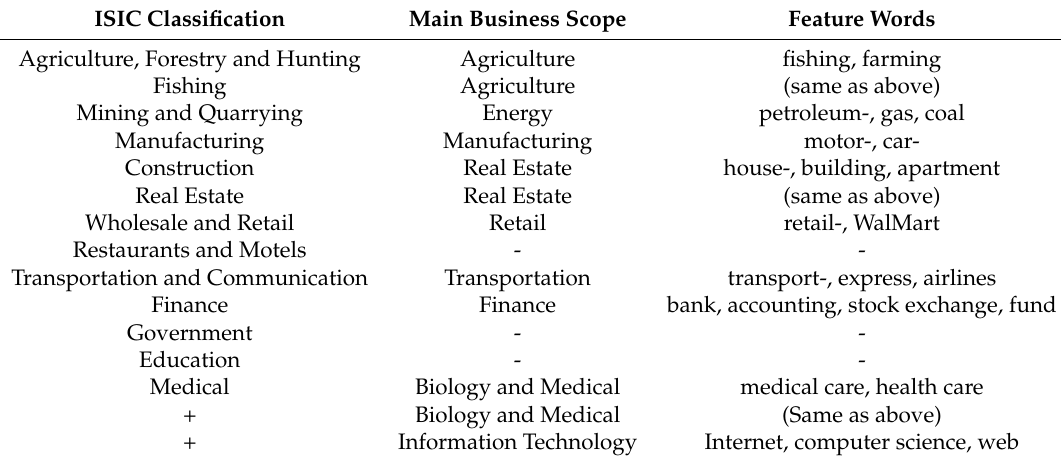
Figure 7. An example for words-of-business-scope-bags. Table 2. Codebook for the main business scopes category (“-” for ISIC classifications not included in our study, “+” for newly defined categories in our study). ISIC: Industrial Classification of All Economic Activities.